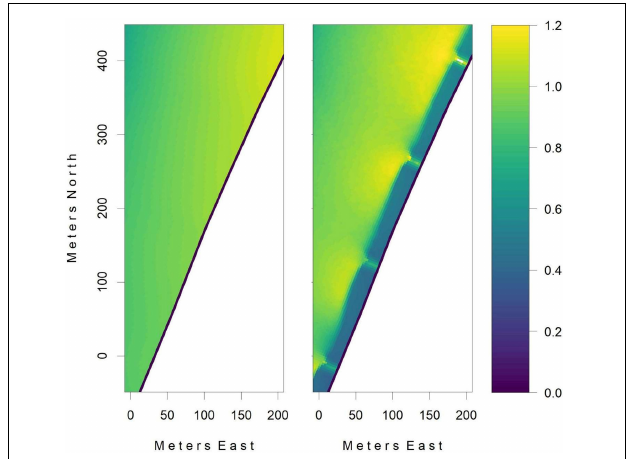
FIGURE 2 | The maximum tidal speeds (in units of m.s − 1 ) of the numerical simulations of tidal flow adjacent to a section of the western bund wall of the Western Basin Reclamation Area are shown without (left) and with (right) the inclusion of a series of subtidal groynes. The series of groynes reduce the maximum tidal bottom stresses sufficiently to guarantee that sediments placed for the purpose of habitat creation are not resuspended, while still being sufficiently low that, in the case of a mangrove habitat, the groynes would become assimilated within the